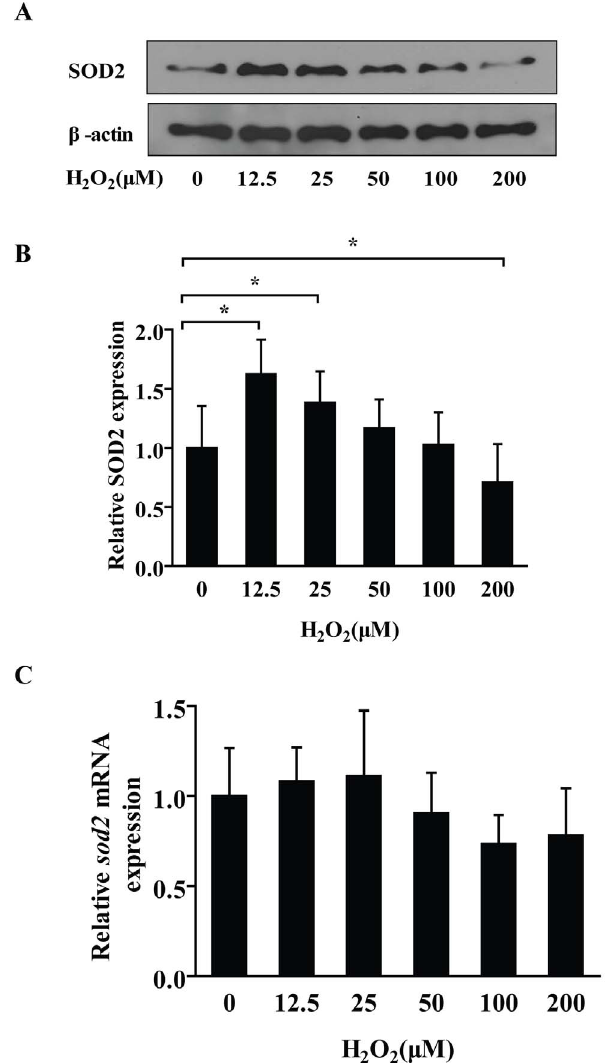
Figure 2. H 2 O 2 down-regulated the expression level of SOD2 protein in a dose-dependent manner. (A) Along with the increase of H 2 O 2 concentrations, the SOD2 protein was decreased gradually. Interestingly, the SOD2 protein showed an evident higher level with 12.5 m M and 25 m M H 2 O 2 stimulation. With the higher concentration 200 m M H 2 O 2 stimulation, it decreased significantly with a lower level than control group. (B) The relative amounts of SOD2, which were represented by the intensity ratio between SOD2 and b -actin in each lane. Data are shown mean 6 SD from 3 independent experiments, each with 6 replicates. (C) H 2 O 2 had no obvious effect on sod2 mRNA expression in PC12 cells. After 6 h treatment with different concentra- tions of H 2 O 2 , the RT-PCR assay demonstrated there were no statistical differences of PC12 sod2 mRNA expression levels between the groups. Data are shown the mean 6 SD (n=6). ANOVA (Dunnett) * P , 0.05, as compared with control.